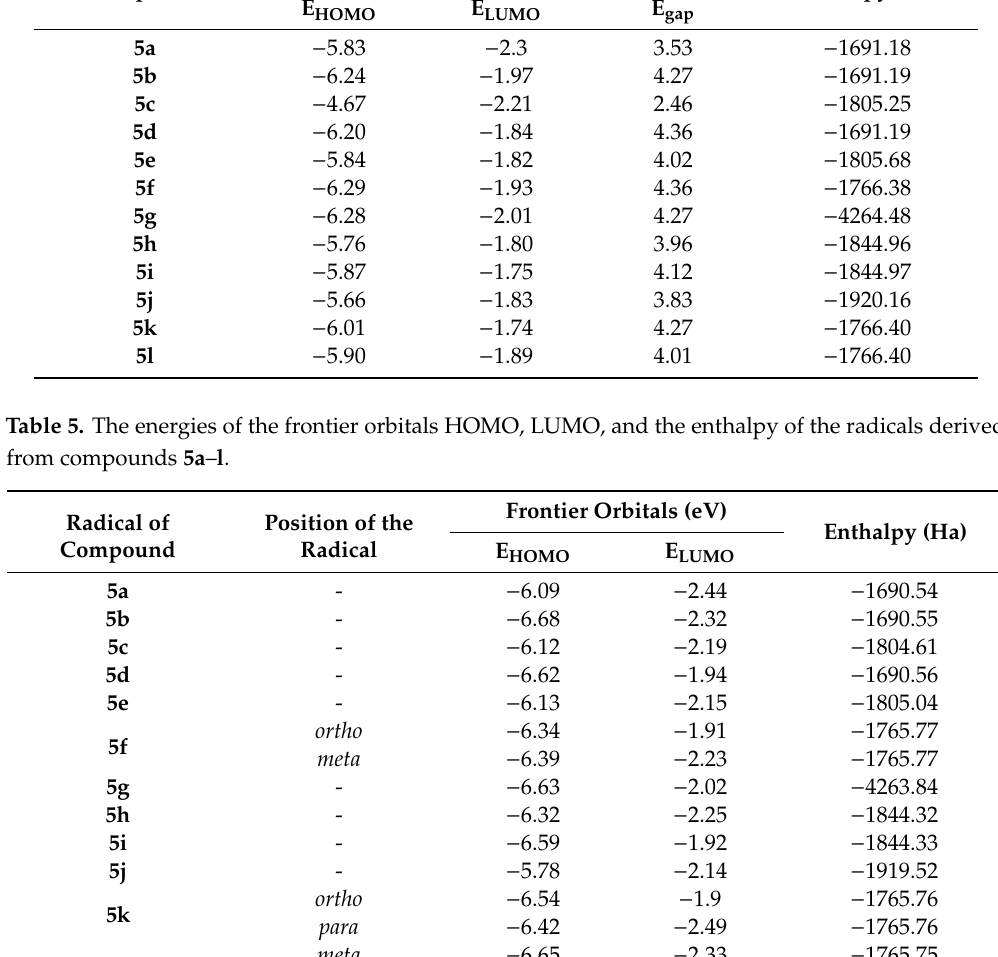
Table 4. The energies of the frontier orbitals HOMO, LUMO, the HOMO − LUMO gap, and the enthalpy of the compounds 5a – l . Frontier Orbitals (eV) Compound